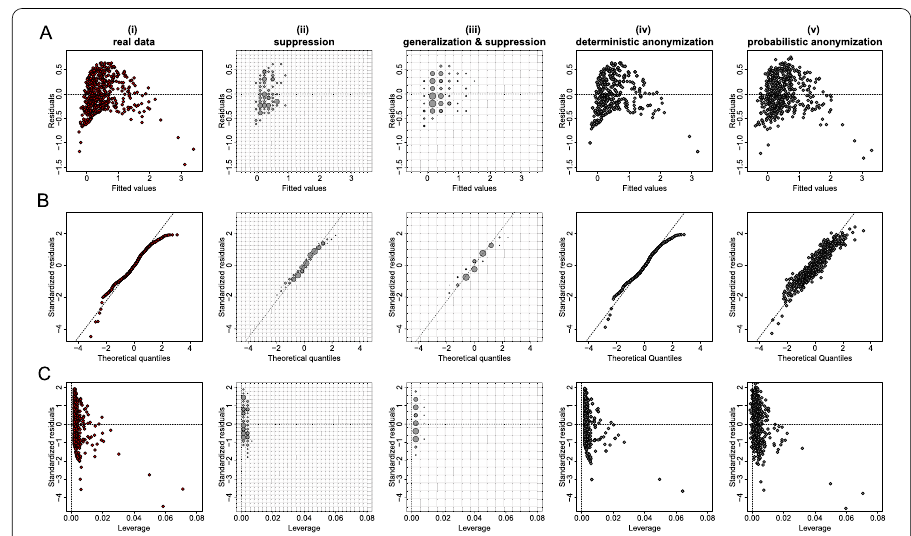
Figure 6 Privacy-preserving regression diagnostic plots of data from dataset D 2. ( A ) Residuals against fitted values; ( B ) Normal QQ plots; ( C ) Residuals against leverage. From left to right we demonstrate the plots: (i) for real regression outcomes; (ii) the regression outcomes aggregated in a 30 by 30 density grid matrix and suppressing any grids with density less than three counts; (iii) the regression outcomes aggregated in a 15 by 15 density grid matrix and suppressing any grids with density less than three counts; (iv) the scaled centroids of each 3-nearest neighbours of the regression outcomes obtained by deterministic anonymization; (v) the noisy regression outcomes obtained by probabilistic anonymization. Note that for plots B and C we use the standardized residuals that are the residuals divided by their standard deviation